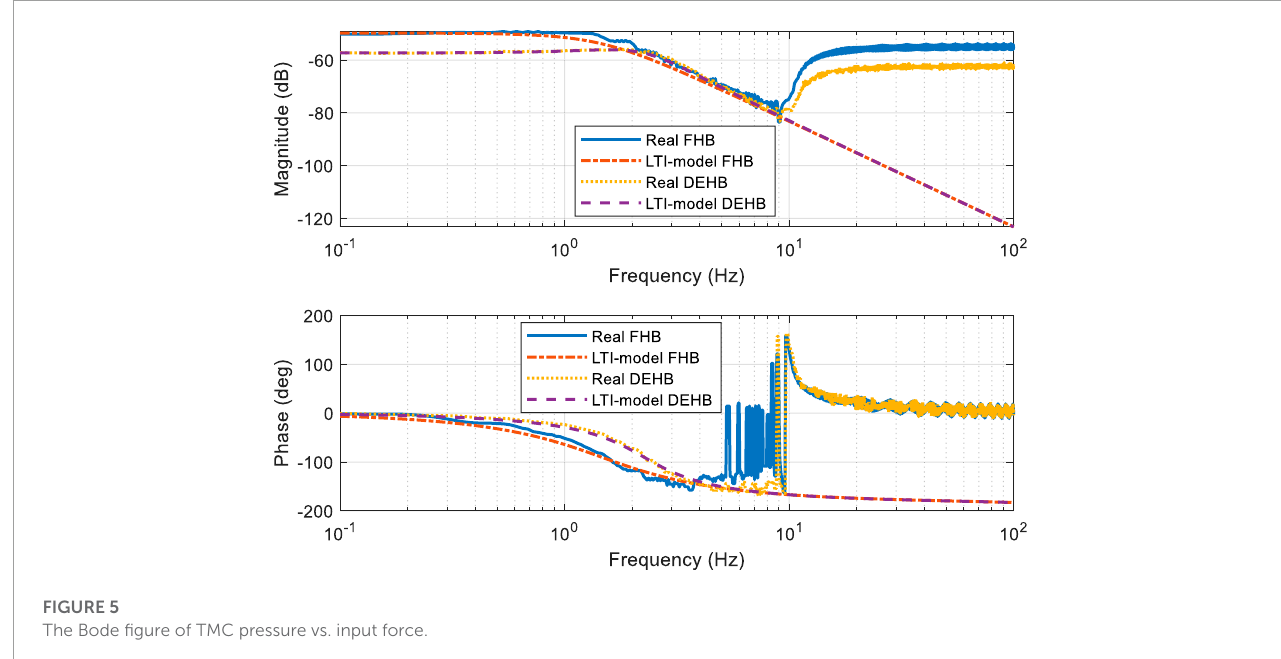
FIGURE 5 The Bode figure of TMC pressure vs. input force.